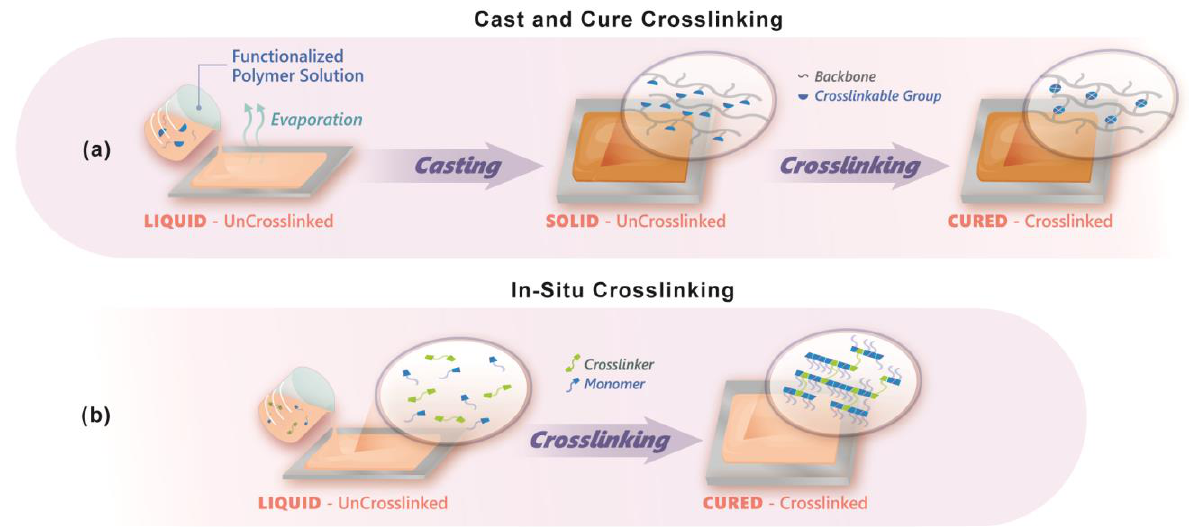
Figure 9. Illustration representing two methods of preparing crosslinked membranes by ( a ) cast and cure method or ( b ) in situ crosslinking.